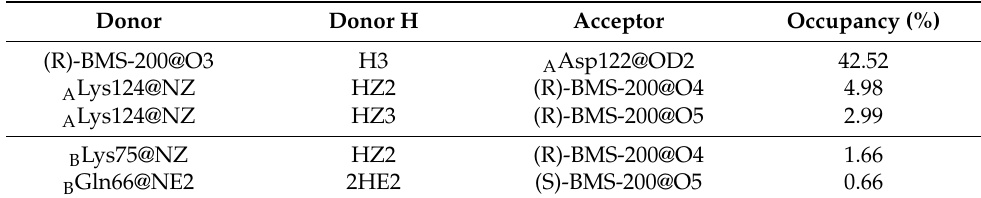
Table 4. Hydrogen bond occupancies of the R